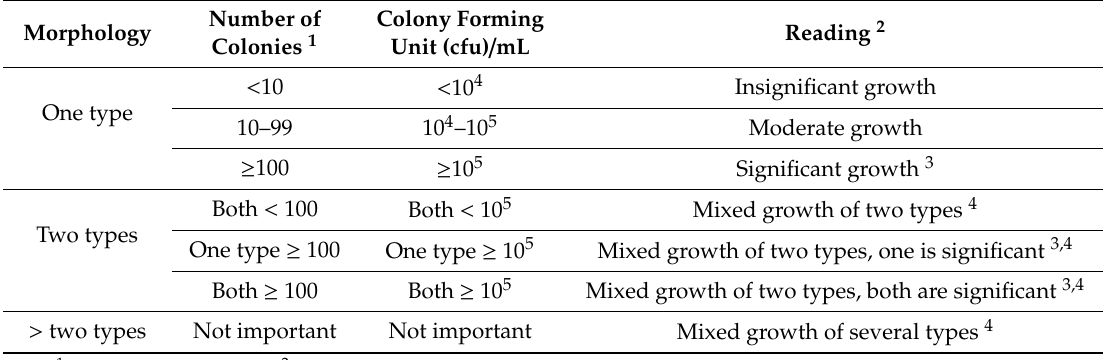
Table 1. Urine culture using the calibrated loop / surface streak method. Interpretation of the urine culture results based on the morphology and number of bacterial colonies.